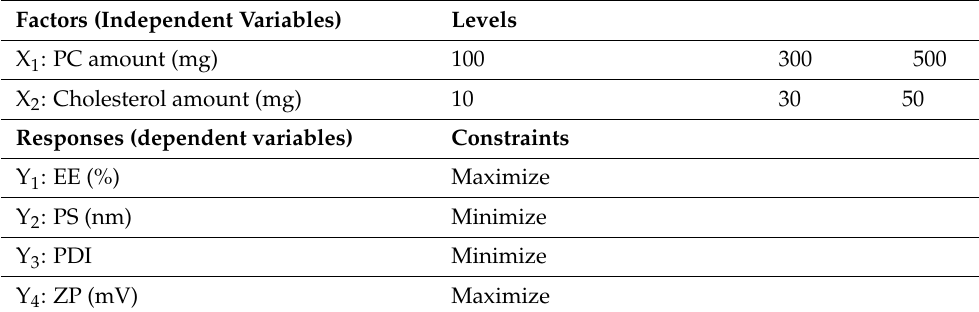
Table 4. Full factorial design for optimization of BEO-loaded